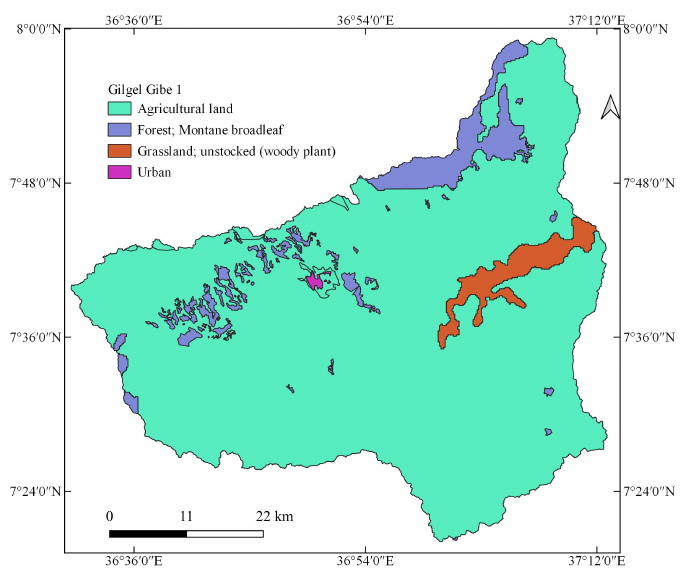
Figure A10. Land use map of Gilgel Gibe 1 Watershed from 1989 to 2009.